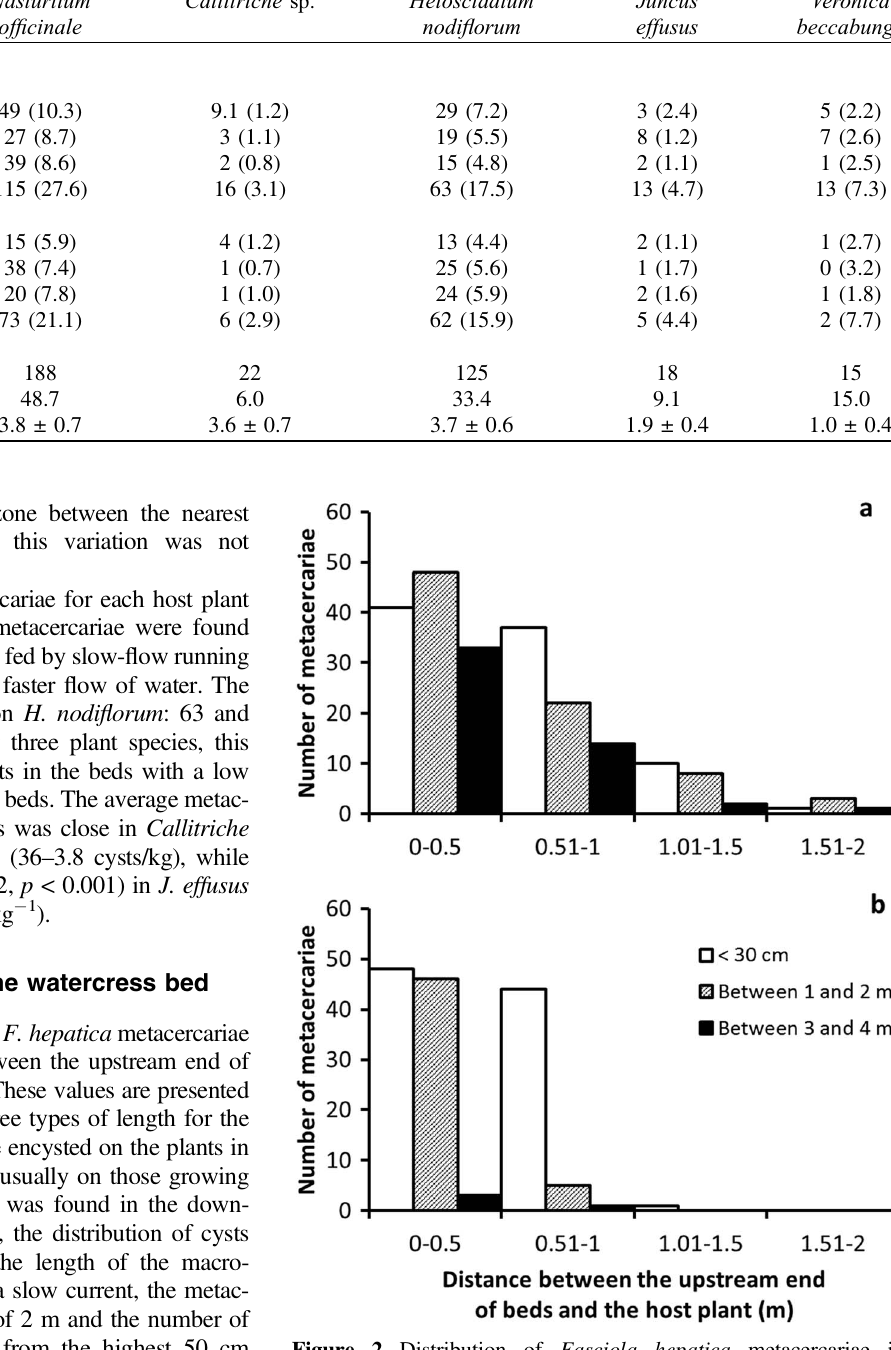
Figure 2. Distribution of Fasciola hepatica metacercariae in relation to the distance between the host plant and the upstream end of each bed: (a) sites fed by a slow- fl owing spring and (b) those fed by a faster current of water. This distance is expressed as 50-cm sections. The three types of length indicated in the legend (graph 2b) are those of the zone without